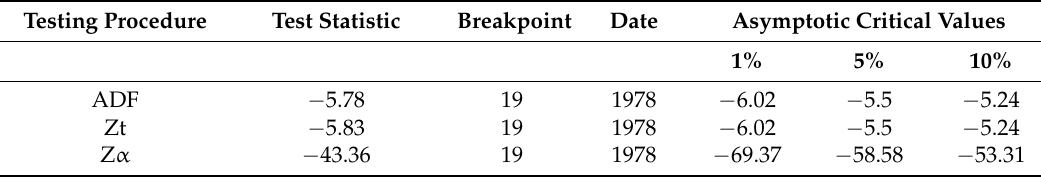
Table 2. Gregory-Hansen Test for Cointegration with Regime